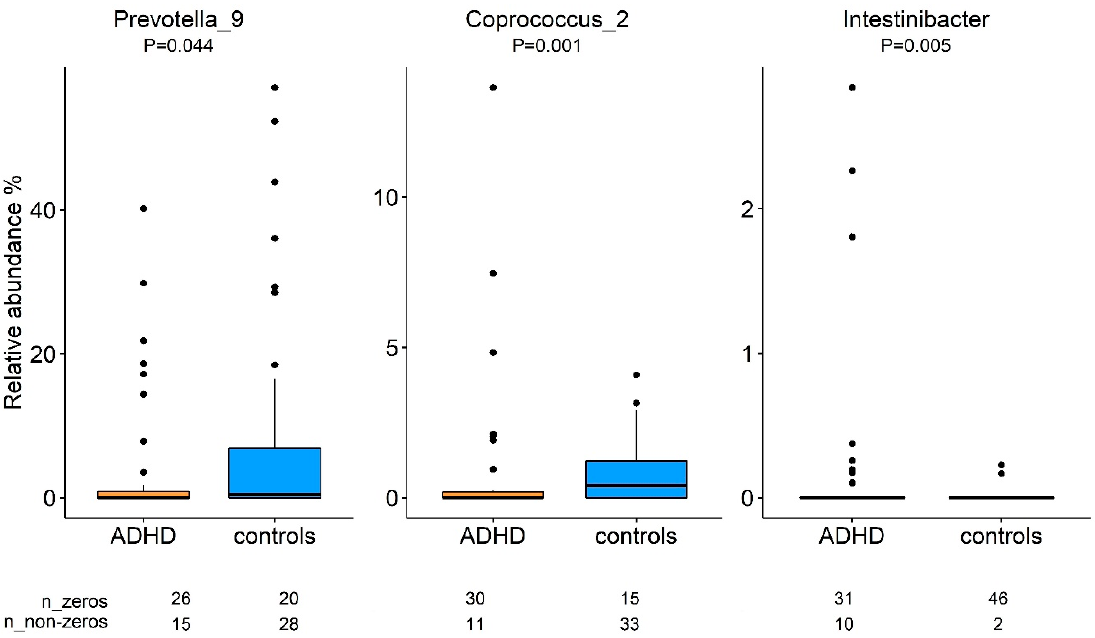
Figure 2. Comparison of bacterial relative abundance between participants with ADHD and controls.